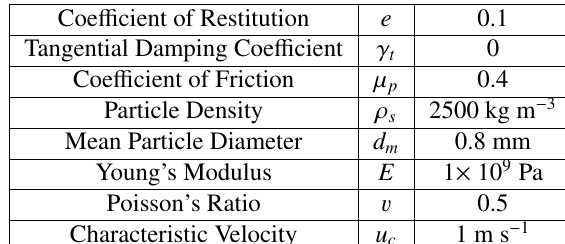
Table 1. List of particle properties used in the DEM